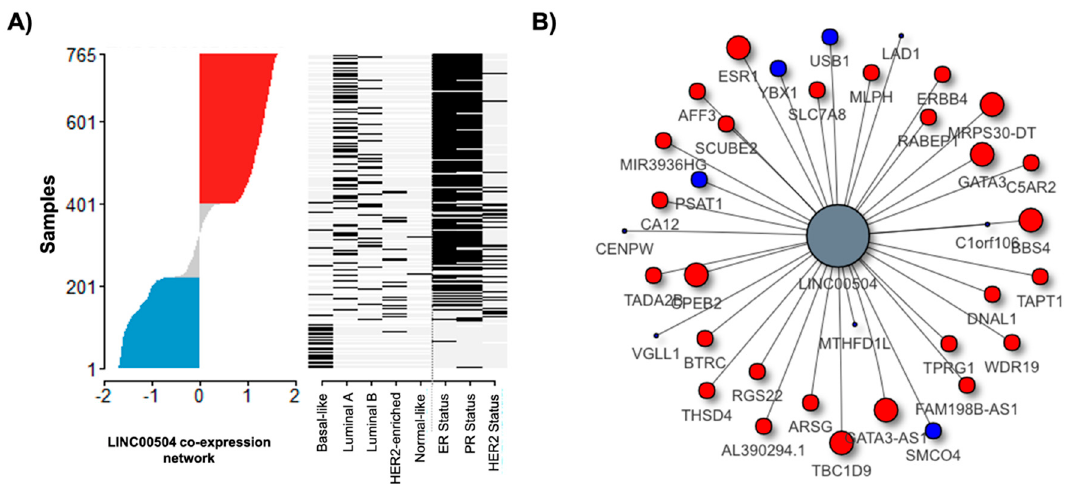
Figure 3. Network activity and LINC00504 co-expression network representation. ( A ) Ranked dES plot for the BC cohort and status of key attributes plot. Each dash in the status attributes plot represents a patient. The cohort of patients was extracted according to their molecular classification and immunohistochemical parameters (estrogen and progesterone receptors and HER2 status). Positive dES, indicated by the color red, represents the up regulation of this network along the samples, whereas negative dES is indicated by the color blue. In this case, positive regulon activity is located in Luminal A patients; ( B ) Network representation of LINC00504 zoomed in on genes with higher mutual information values. Red circles refer to genes with positive correlation and blue to negative ones. Dot size refers to the mutual information value, where big dots indicates higher mutual information.